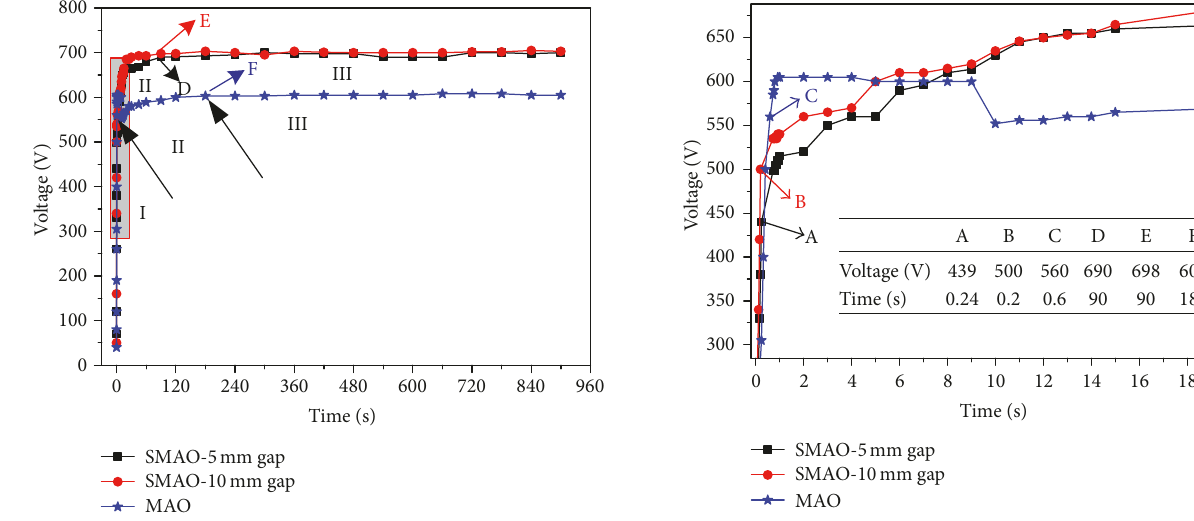
Figure 7: Transient voltage-time response curves for SMAO (5 and 10 mminterelectrodegapsandstationaryanode)andMAOforA356